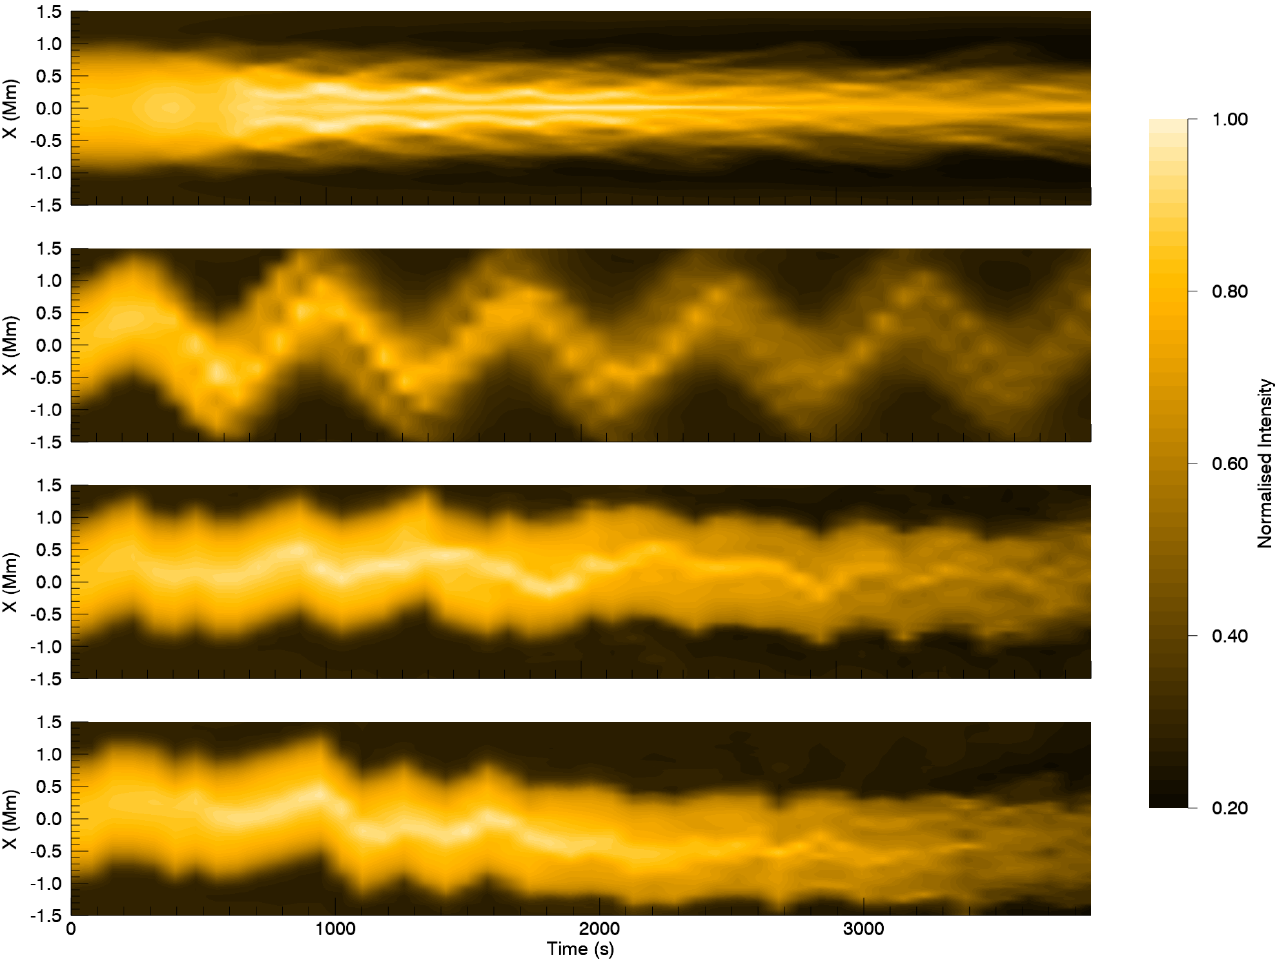
Figure 13. Time–distance dependence of 171Å emission from a cut across the loop apex: the ResUni simulation viewed with a LOS parallel to the y axis ( top ) and parallel to the x axis ( top second plot); the ResMulti ( third plot) and BbMulti simulations ( bottom ) with the viewing angle is parallel to the y axis. All plots are normalised by the maximum intensity in the ResUni simulation. See text for